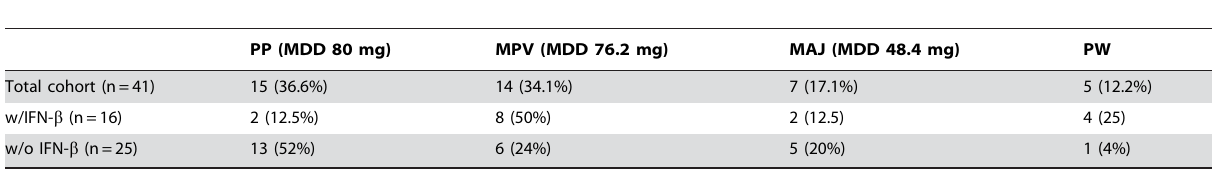
Table 5. Number and percentage of patients treated per protocol (PP; 80 mg atorvastatin daily), with minor protocol violations (MPV; mean daily dose (MDD) at least 70 mg atorvastatin daily), with major protocol violations (MAJ; mean daily dose less than 70 mg atorvastatin daily) or with premature withdrawal before completing 6 months of treatment (PW).